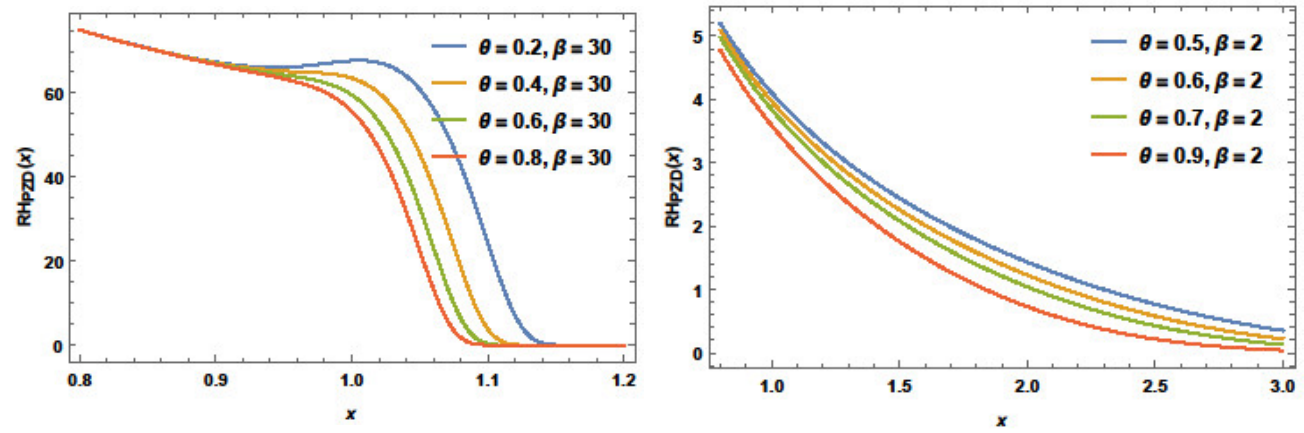
Figure 7. The odds function plots of PZD for selected values of parameters.